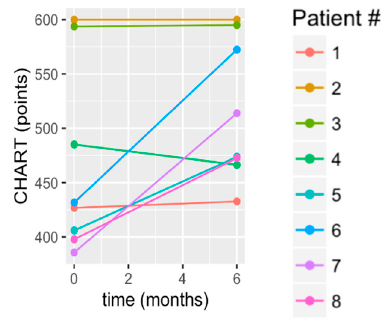
Figure 8. Change in Craig Handicap Assessment and Reporting Technique (CHART) from baseline to 6 months.